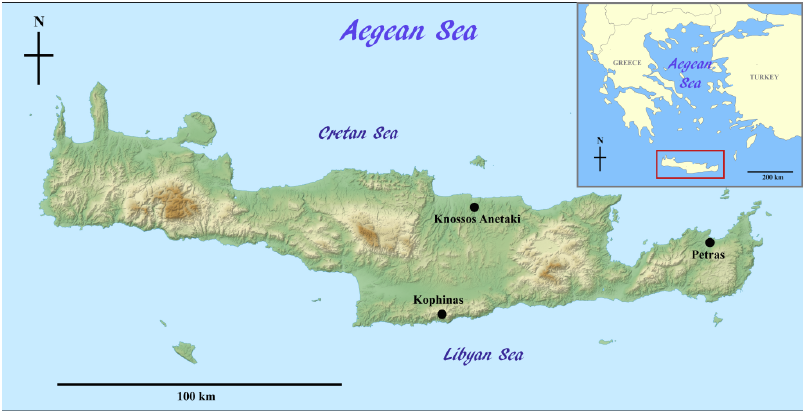
Figure 1. Map of Crete showing the three Bronze Age ritual sites (modified from: Crete_relief_map- fr.svg: Eric Gaba [Sting—fr:Sting] derivative work: Xfigpower [pssst]—Crete_relief_map-fr.svg, CC BY-SA 3.0, https://commons.wikimedia.org/w/index.php?curid=11905589, public domain Wiki Commons, accessed on 30 September 2021).